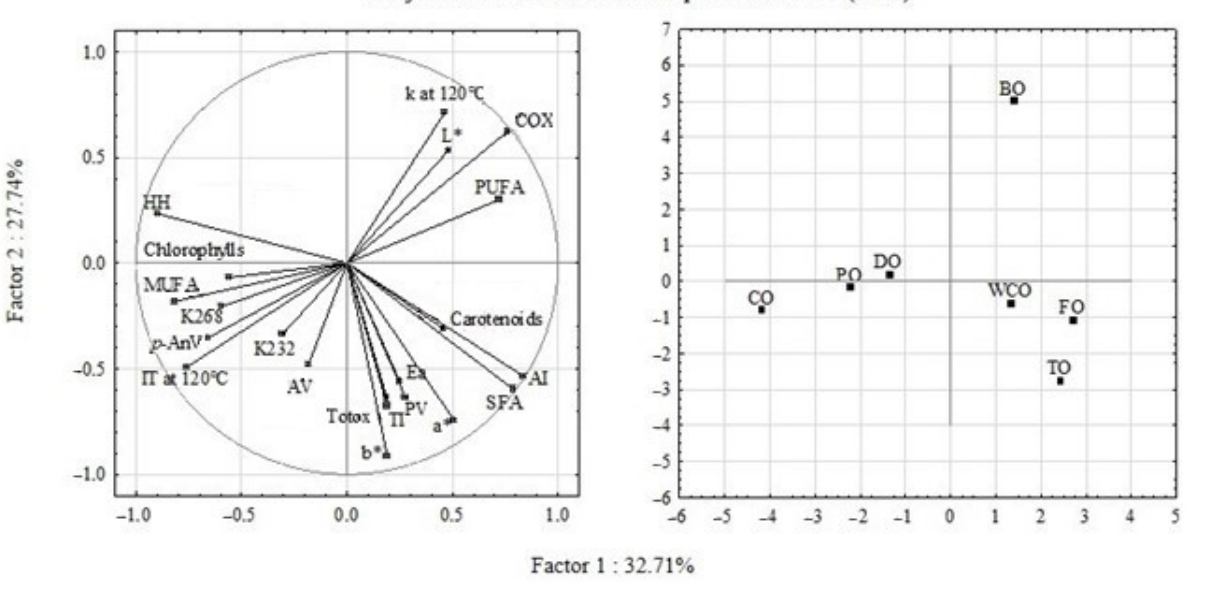
Figure 1. PCA bi-plot based on quality parameters of analysed oils.